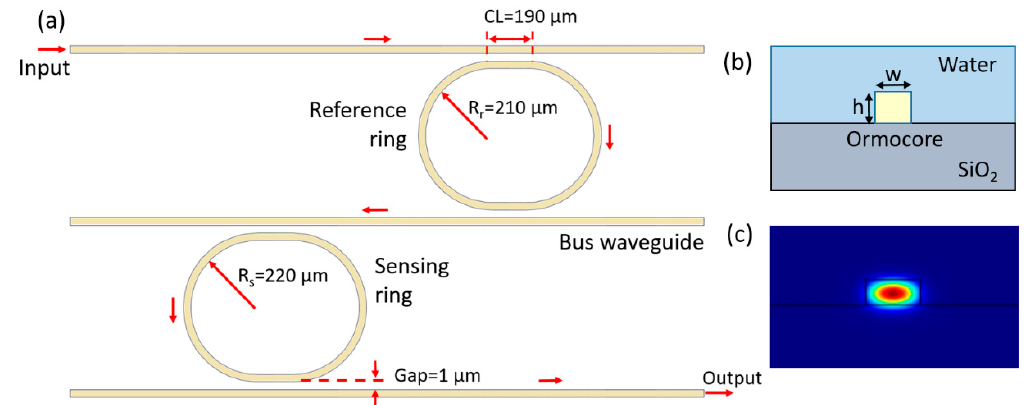
Figure 1. ( a ) The schematic configuration of the two-cascaded-microrings biosensor based on the Vernier effect. ( b ) Cross-section of the polymer-based waveguide. ( c ) Propagating mode in the polymer-based waveguide.